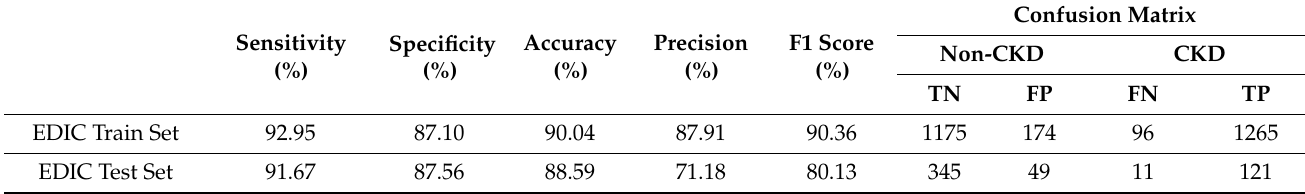
Table 4. Performance analysis of the final model on the train and test